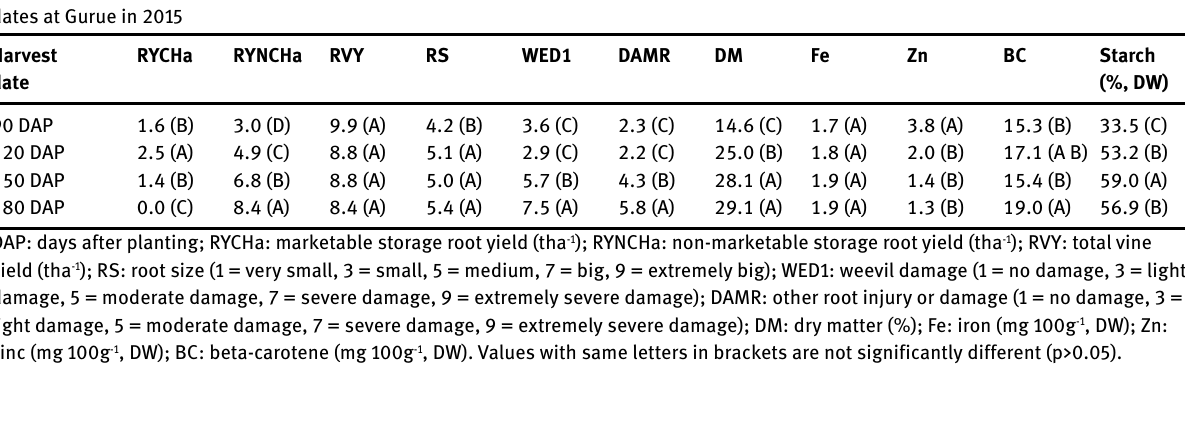
Table 3: Means for storage root yield, vine yield, root size, weevil damage and nutritional traits measured across four different